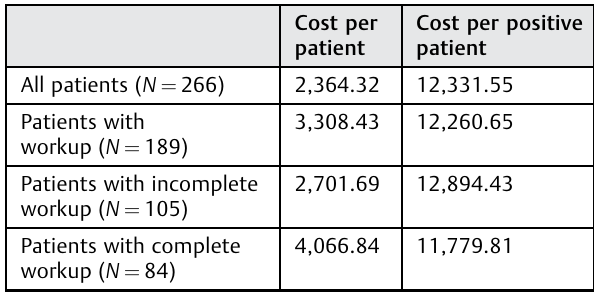
Fig. 3 Appropriateness of thrombophilia test repeats ( N ). AT, antithrom- bin; FVL, factor V Leiden; PC, protein C; PS, protein S; PT, prothrombin.